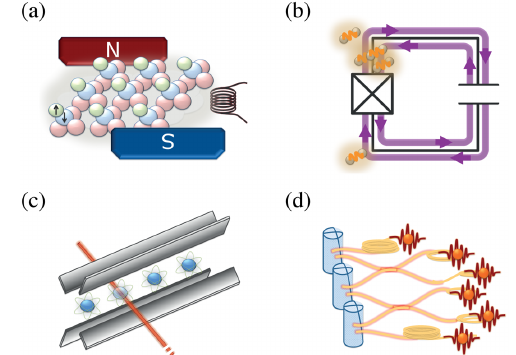
FIG. 1. Cartoon representation of the quantum processing architectures used in this work. (a) NMR device at the University of Oxford [7], (b) superconducting circuits at IBM [31] and Rigetti Computing [32], (c) a trapped-ion quantum processor at the University of Innsbruck [8], and (d) a photonic quantum processor at the University of Vienna